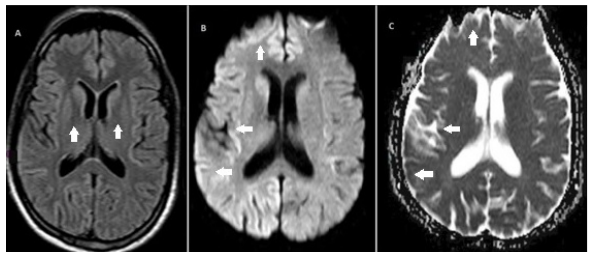
Figure 1. Brain MRI. Panel A show hyperintensity in bilateral striatum in the FLAIR sequence. Panels B and C shows water restriction in cortex with a predominance in the right hemisphere (DWi/ADC